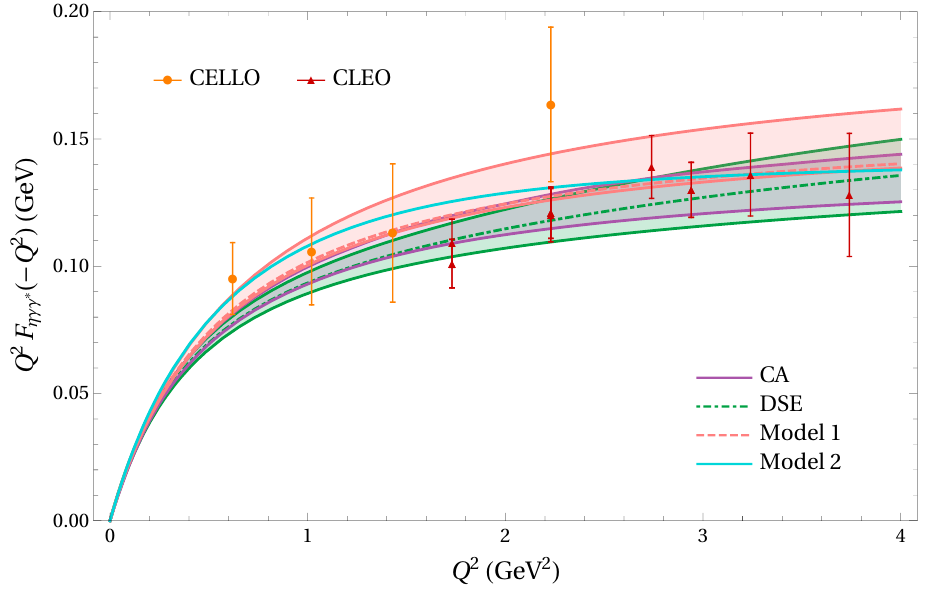
Figure 28. Singly-virtual (cid:17) TFF in the low- Q region. The large- N c Regge model, \Model 1" (4.34), is indicated by the pink band with the dashed curve. Our alternative TFF model, \Model 2" (B.1), is indicated by the solid cyan curve. The purple band is the CA result from ref. [49]. The green band with the dot-dashed curve is the DSE result from ref. [50]. The data are from CELLO [115] and CLEO [116].